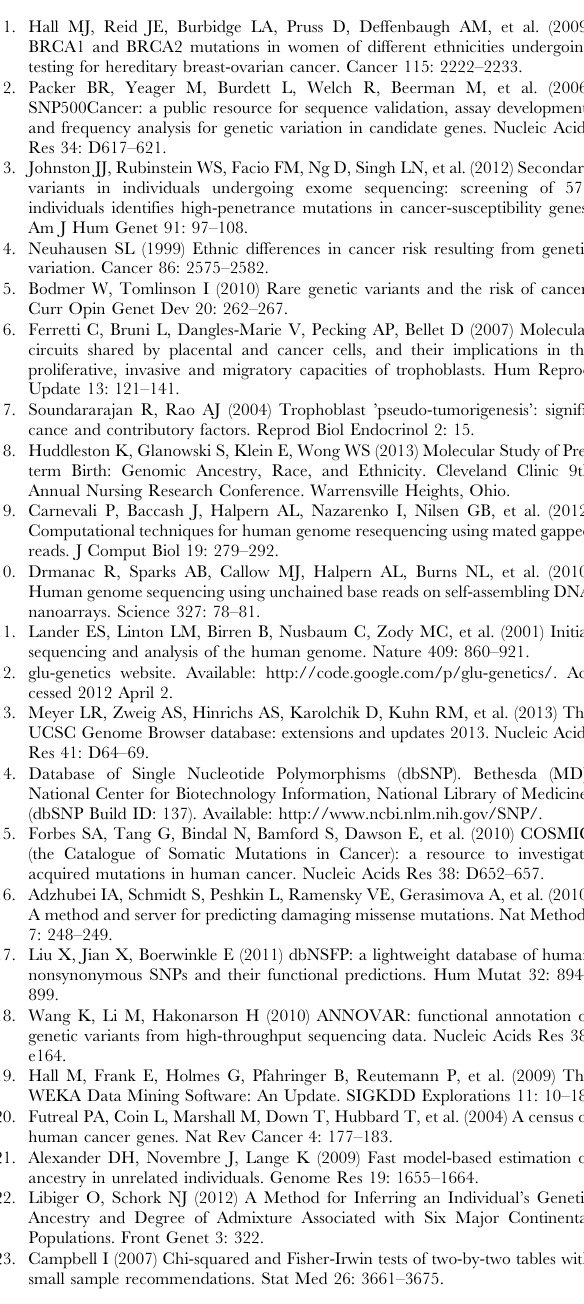
Figure S1 Sequence coverage. Plot of the coverage for all coding bases in each gene for each individual. There are between 327,000 and 11,300,000 points plotted per gene, depending on total coding length. Genes are arranged by chromosome. File S1 Supporting tables. Table S1, Variants in cancer- susceptibility genes observed in the cohort. Table S2, Positions with a minor allele in the reference sequence. Table S3, Common variants with ancestry-dependent allele frequencies. Table S4, Per- gene